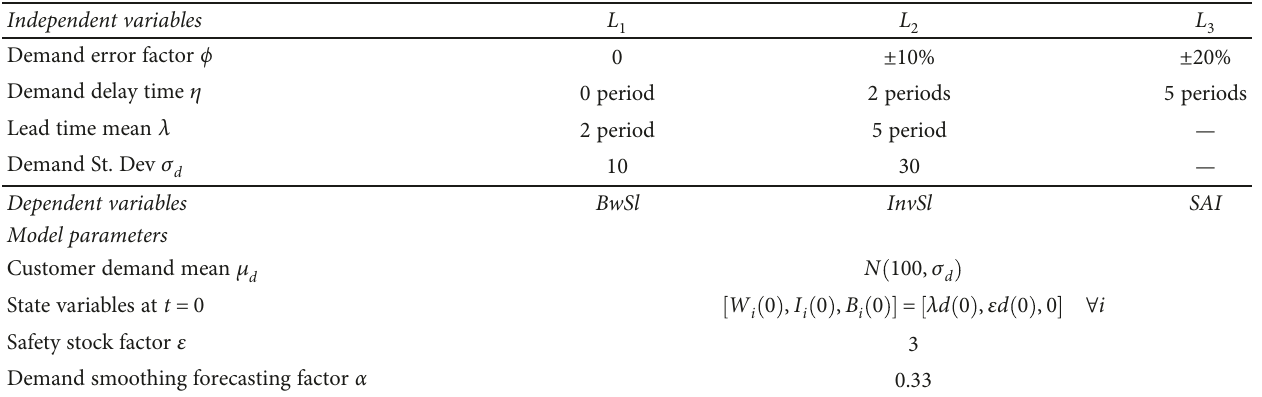
Table 6: Experimental